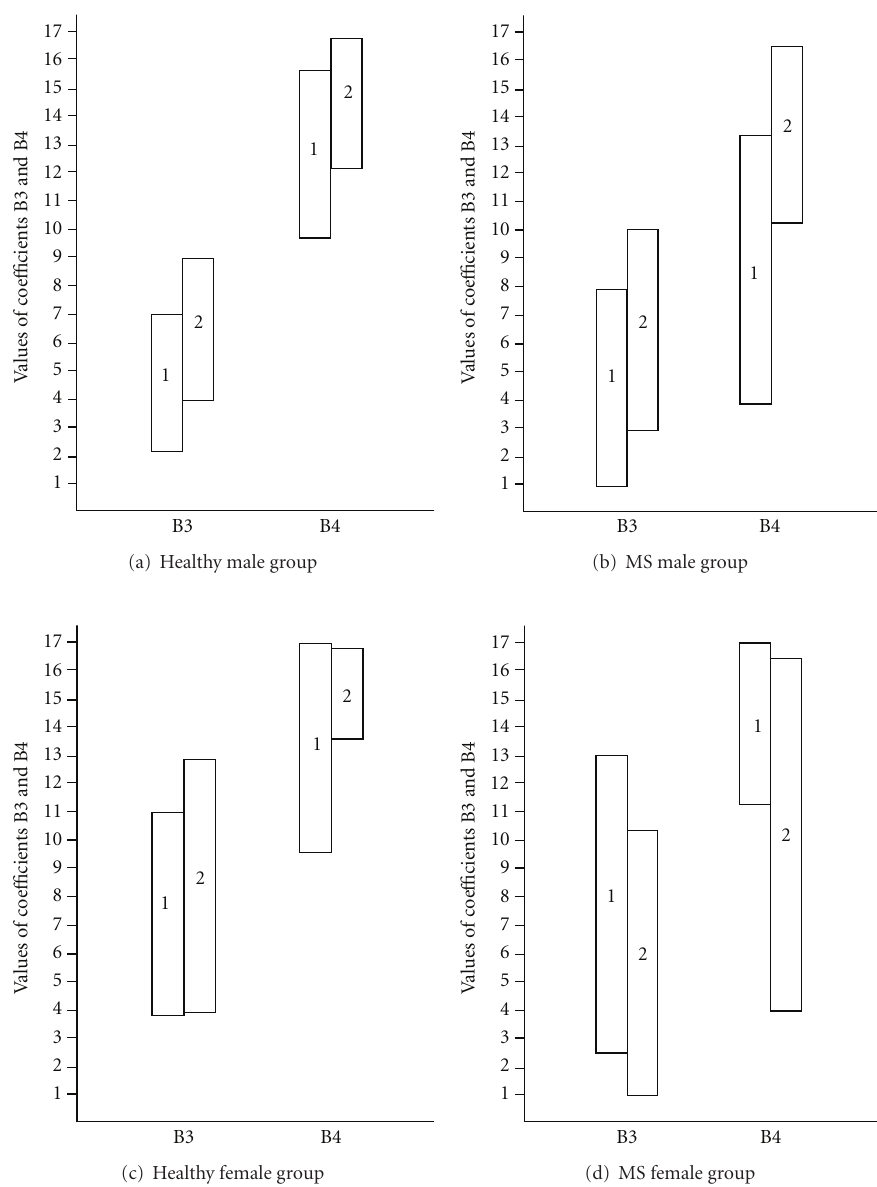
Figure 2: Overlapping of B 3 or B 4 values between clusters after clustering CVLT-II measures trials 1–5. (a) Healthy male group; (b) MS male group; (c) Healthy female group; (d) MS female group. 1 is the range of the cluster referring to lower memory functioning; 2 is the range of the cluster referring to higher memory functioning. Identification of coe ffi cients is given on the abscissa. This figure illustrates that clustering of raw recall scores does not allow distinguishing between B 3 and B 4 due to considerable overlapping of each coe ffi cient’s values between cluster referring to lower memory functioning and cluster referring to higher memory functioning from healthy participants and MS